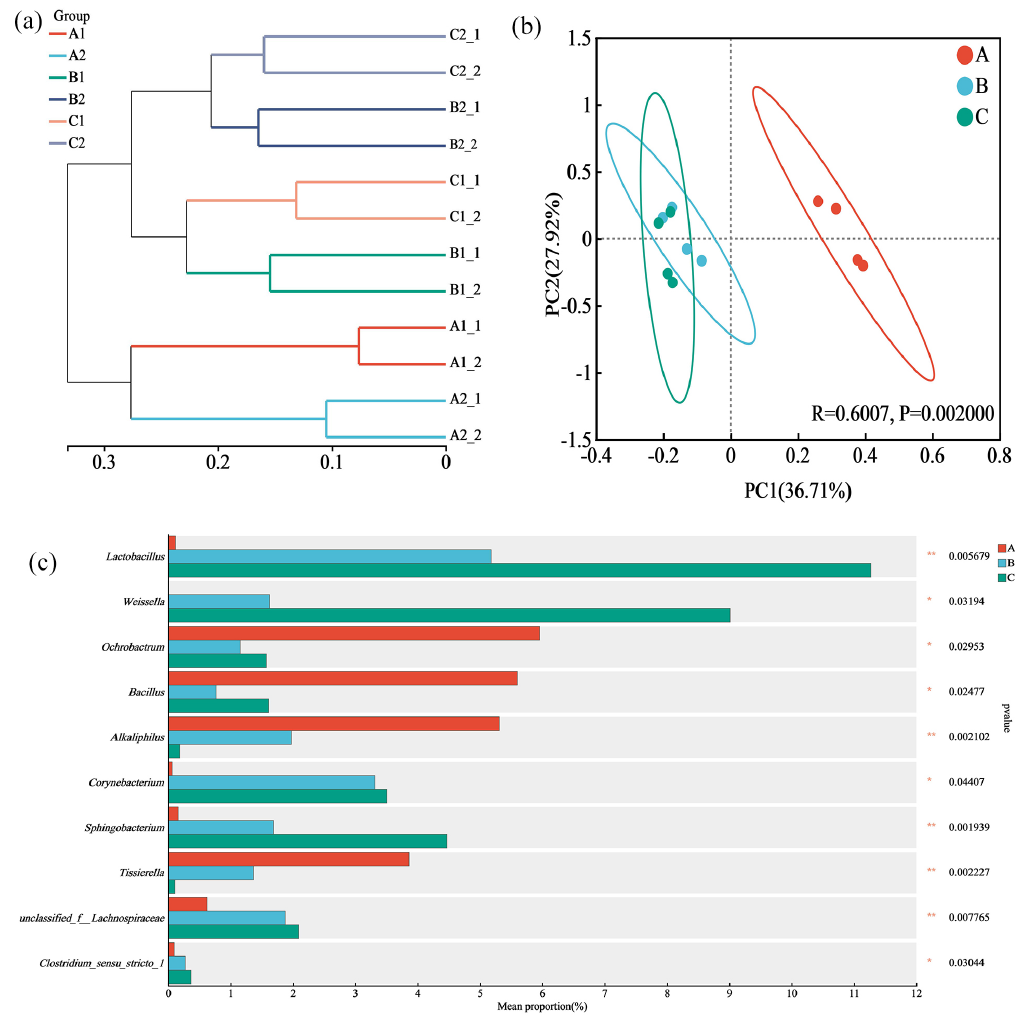
Figure 3. ( a ) Hierarchical clustering analysis of bacterial samples; ( b ) PCoA analysis of the three bacterial flora samples; ( c ) comparison of the top 10 genera for multi − group. The statistical analysis was performed using one − way ANOVA, with fdr for p −value multiple tests. * 0.01 < p < 0.05, ** 0.001 < p < 0.001. A, B and C denoted all samples collected on day 7d and 10d, in groups treated by microorganisms A, B and